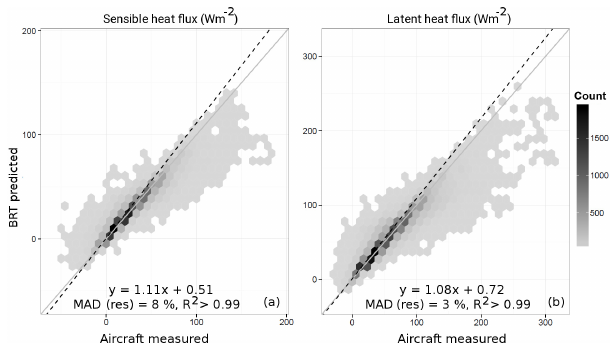
Figure 7. Scatterplot with hexagonal binning of the measured (air- borne survey) and BRT predicted sensible heat (a) and latent heat (b) fluxes. Altogether 21529 data points were used for the sensible heat flux scatterplot and 25608 for the latent heat